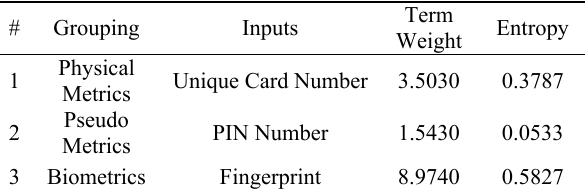
Table 2: Term weight and entropy input values for the artificial neural network.